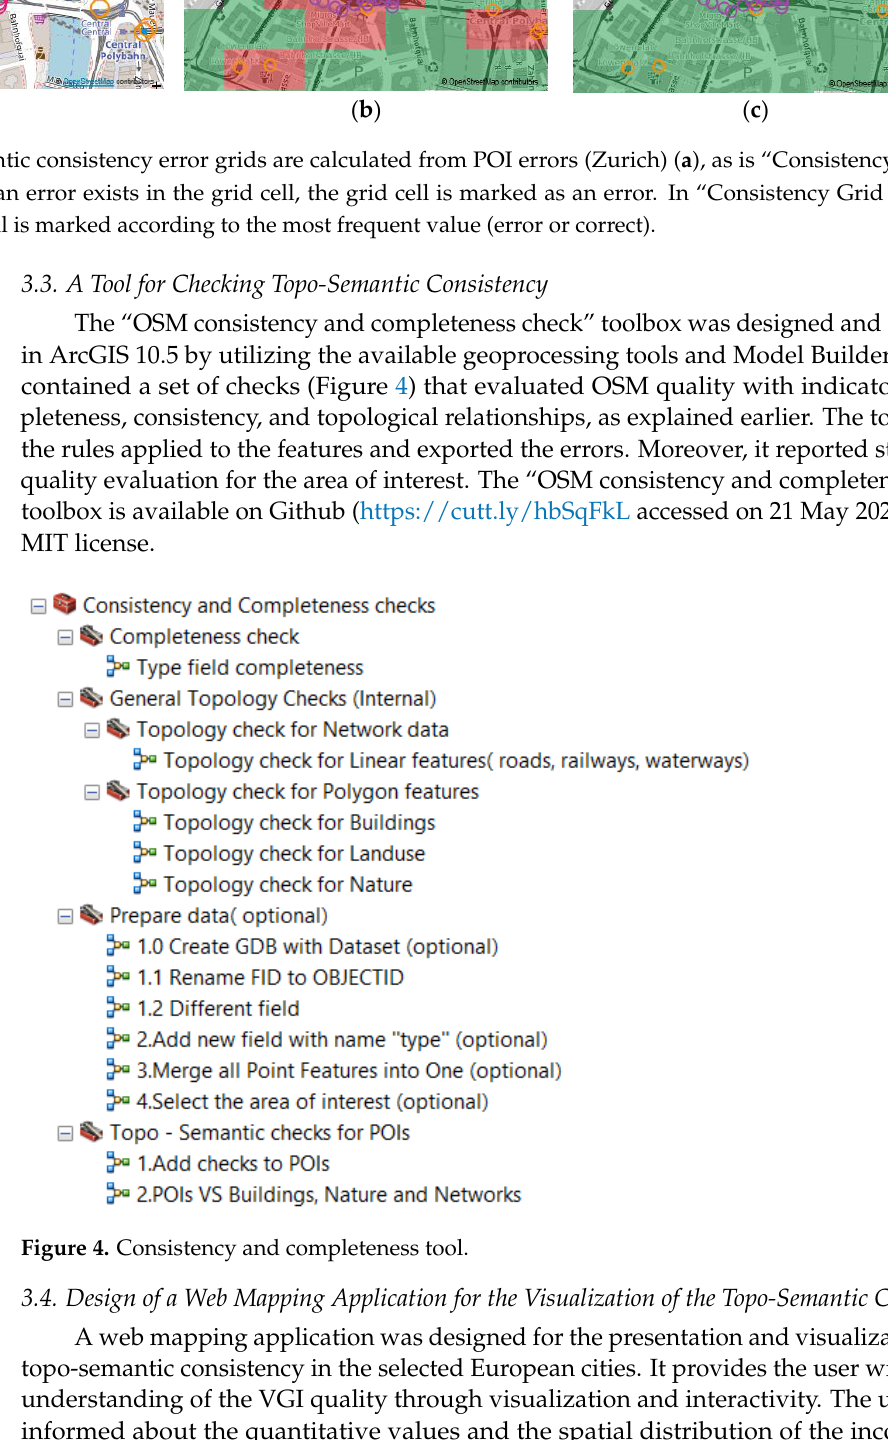
8 of 34 Figure 2. Topo-semantic checks. Check 1: “POIs must be inside buildings” ( a ); Check 2: “ POIs must be outside of roads” ( b ); Check 3: “POIs must be outside of buildings” ( c ); Check 4:” POIs must be on roads” ( d ); Check 5: “POIs must be outside of nature” ( e ); Check 6: “POIs must be on railways” ( f ). Besides that, the distance of each POI to the thematic layer participating in the con- straint was calculated [11]. Errors with small distances were due to the zoom level used during data entry [55]. The distance values supported the critique of the severity of the deviation at the map scale. Since the deviation was often minimal, it could be considered negligible at a map scale if the data were intended for portrayal only. Additionally, the distances could be compared to characteristic quantities at the city scale, such as the pave- ment size and road size [17]. For the use of the data in spatial analysis, of course, all devi- ations were errors. The results of each topo-semantic check (Figure 3a) were summarized for each city with error percentages. In this way, the cities could be examined in comparison. The error and correct percentages could be visualized for a set of cities in a map, thus providing visualization at a regional level (e.g., Europe). However, they could not be summarized into a global Europe index because the cities were not systematically selected. In order to summarize the results of all topo-semantic checks and capture the spatial distribution of inconsistency at the city level, a topo-semantic consistency error grid was proposed. Two types of topo-semantic consistency error grids were proposed. In the first one, called a